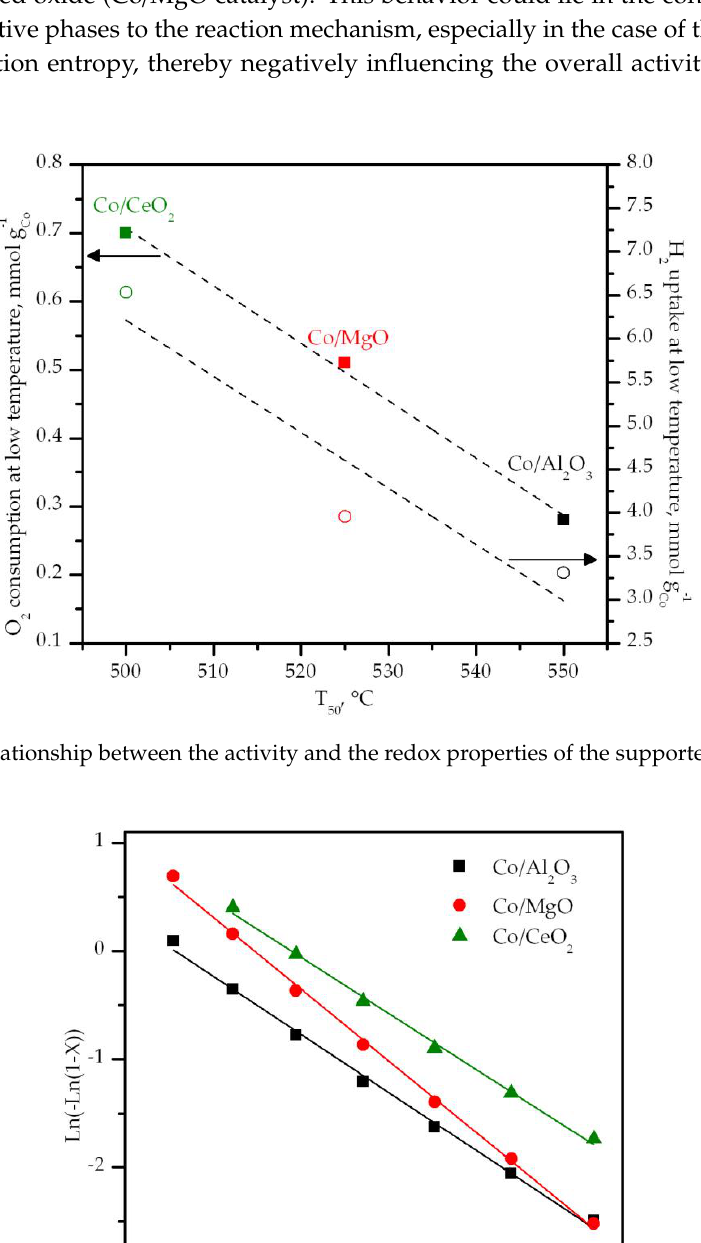
Figure 7. Light-off curves of the supported cobalt catalysts.